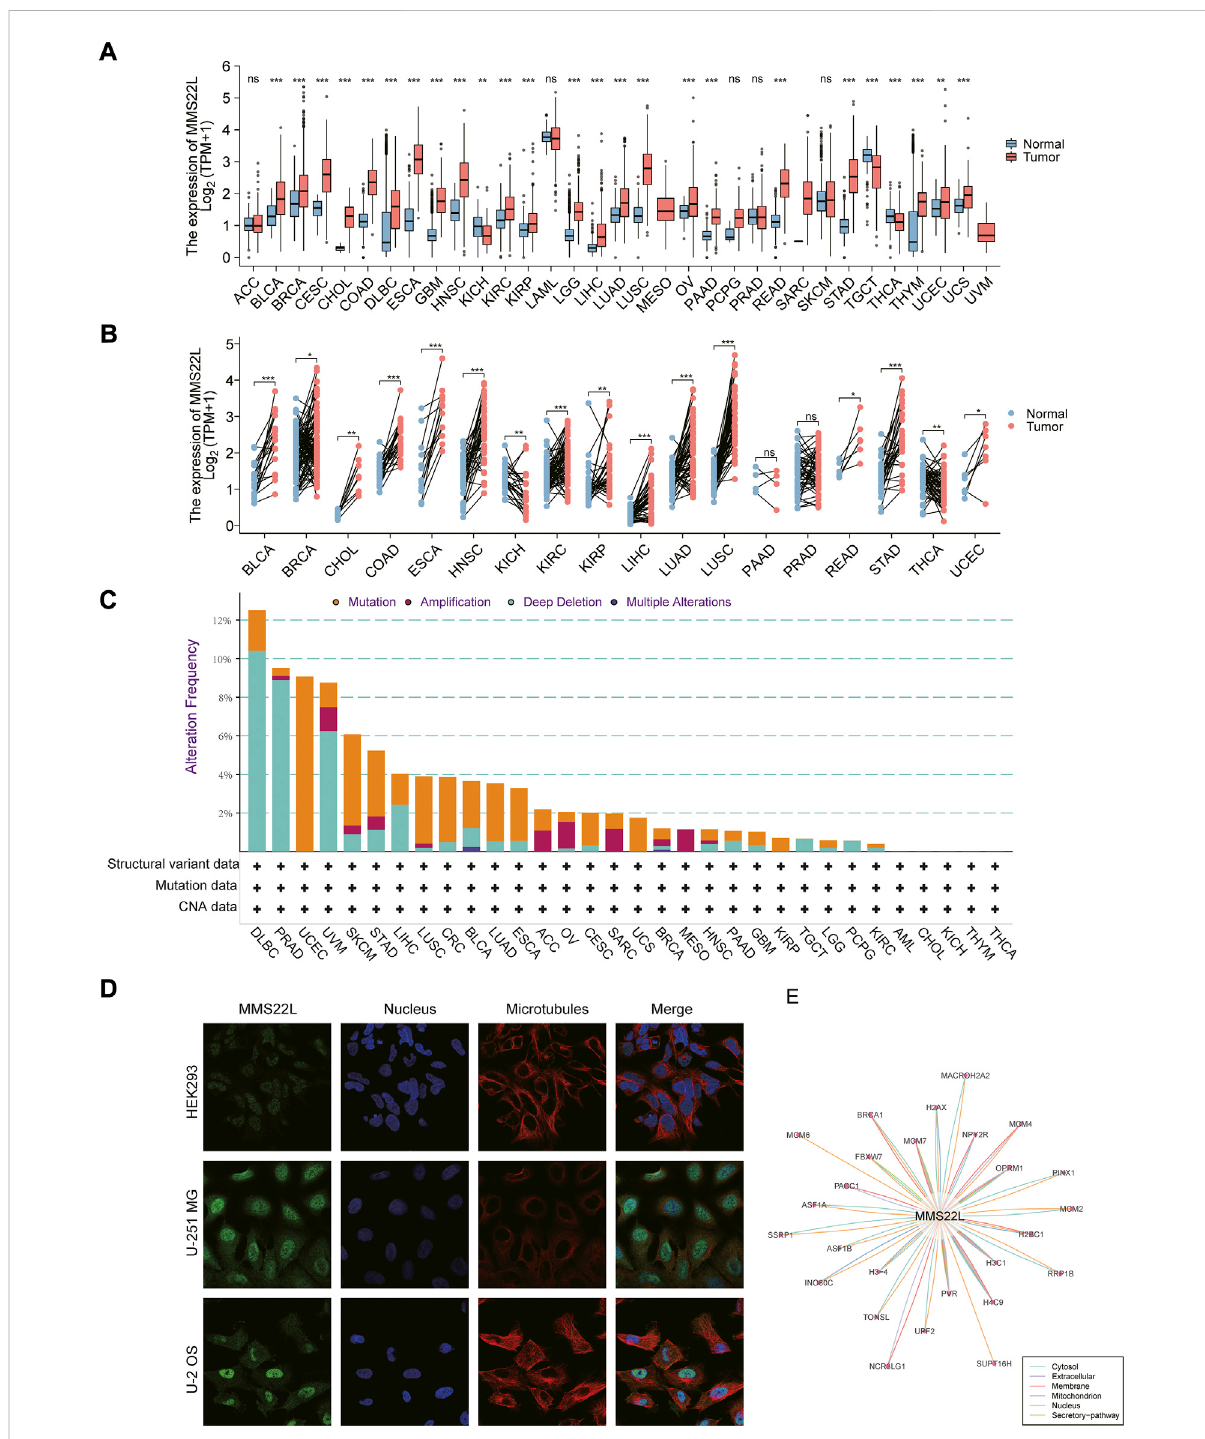
FIGURE 1 Basic information about methyl methanesulfonate-sensitivity protein 22-like (MMS22L) in pan-cancer. (A) Differential expression of MMS22L based on The Cancer Genome Atlas and Genotype-Tissue Expression databases in pan-cancer. (B) Paired analysis of MMS22L expression in pan- cancer. (C) The landscape of MMS22L genomic alterations in pan-cancer according to the cBioPortal database. (D) Immuno fl uorescence images depicting localization information of MMS22L protein in HEK 293, U-2 OS, and U251 MG cell lines. (E) Protein-protein interaction network formed by MMS22L. ns, p ≥ 0.05; *, p < 0.05; **, p < 0.01; ***, p <